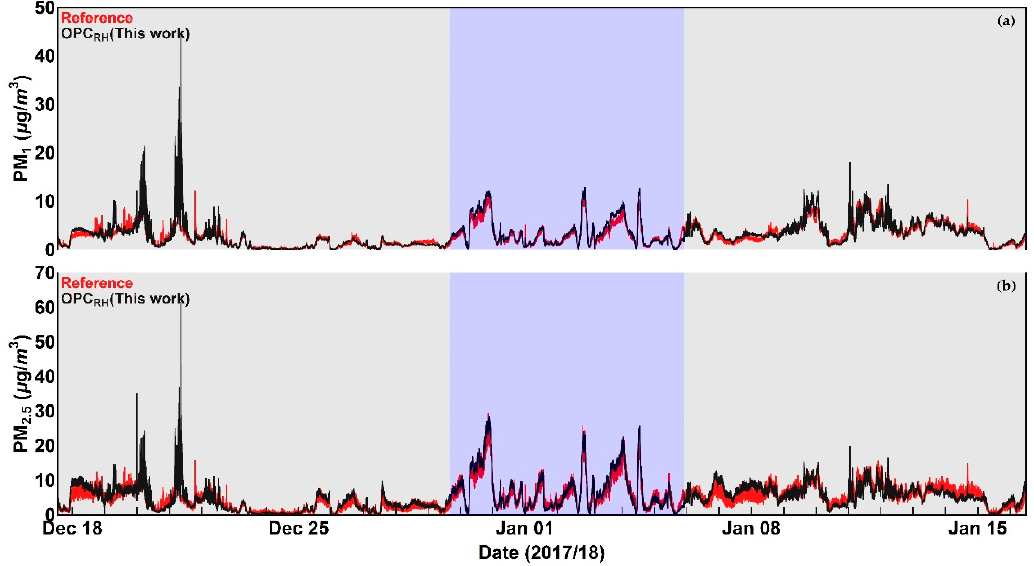
Figure 14. Time series plots of OPC PM measurements in comparison with reference data after the application of the correction algorithm assuming Ammonium Sulphate (grey shaded area) and Sodium Chloride (blue shaded area) as unique particle chemical species for: ( a ) PM 1 ; ( b ) PM 2.5 .